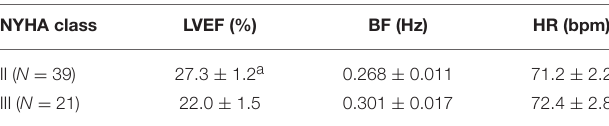
TABLE 2 | Cardiac and respiratory parameters of heart failure patients in regard to NYHA functional capacity.